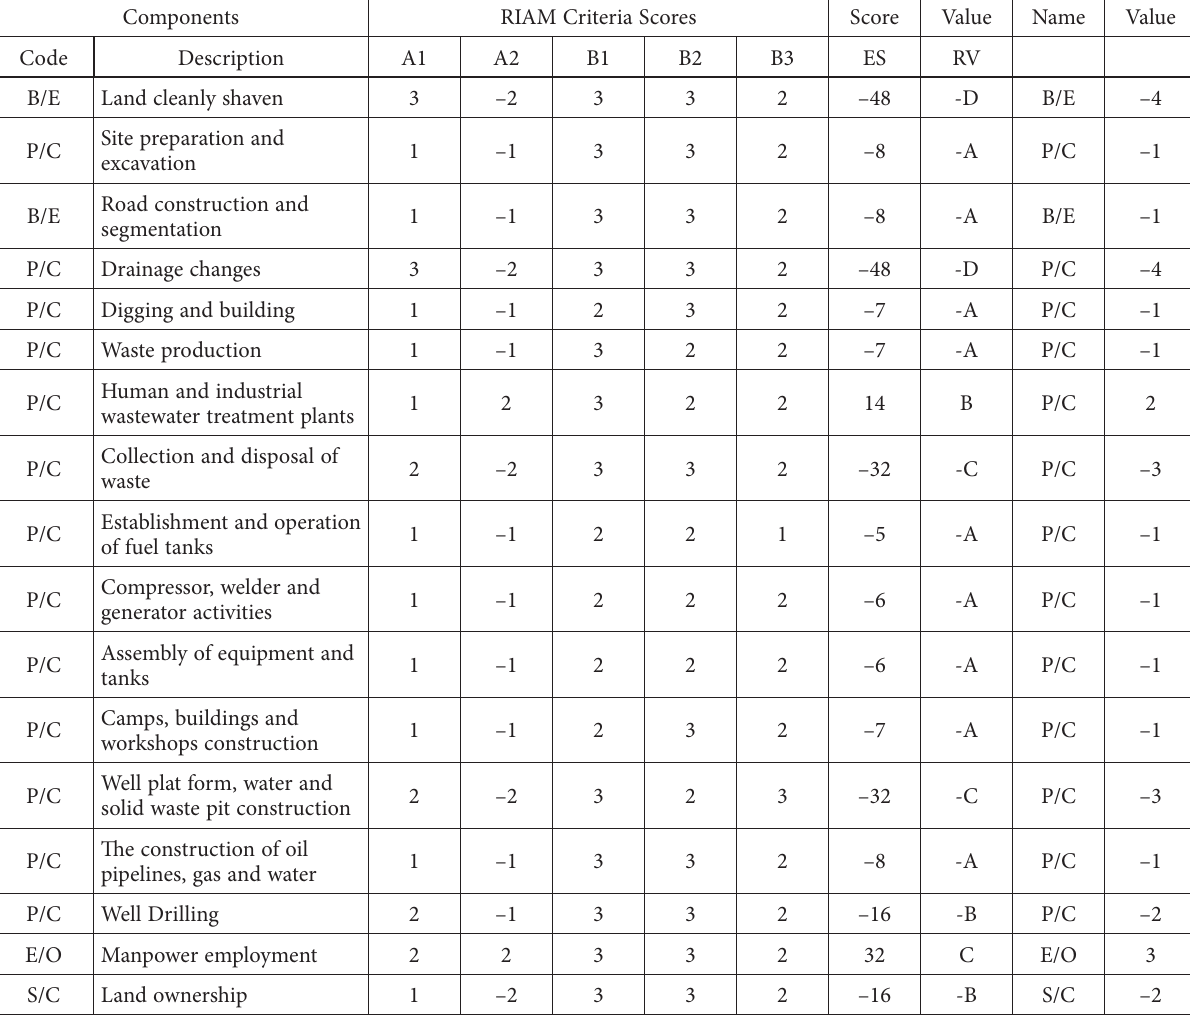
Table 8. Pastakia matrix in constructional phase